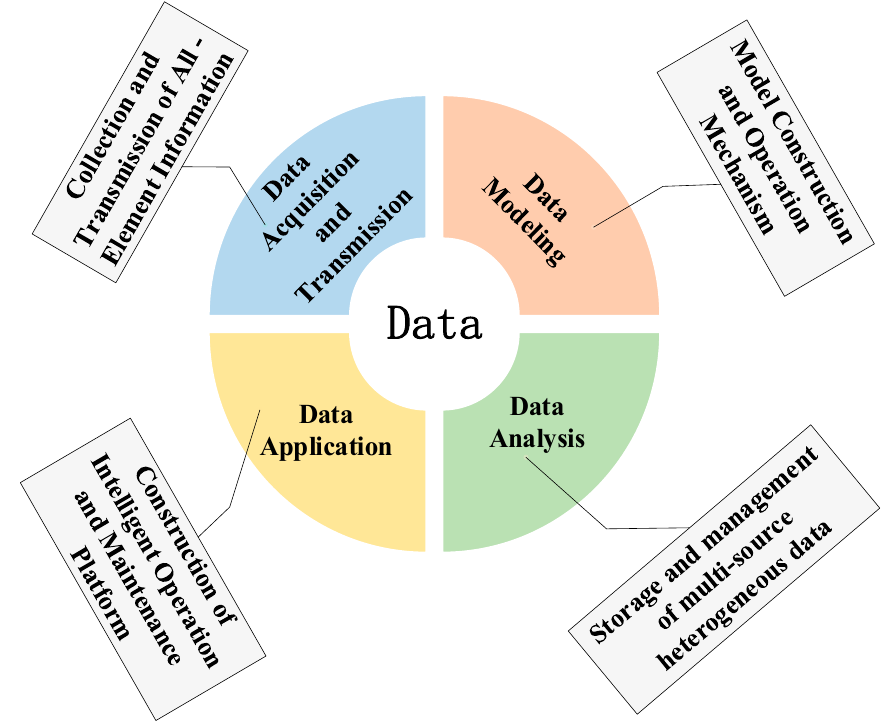
Figure 2. Key issues of DTs application in intelligent